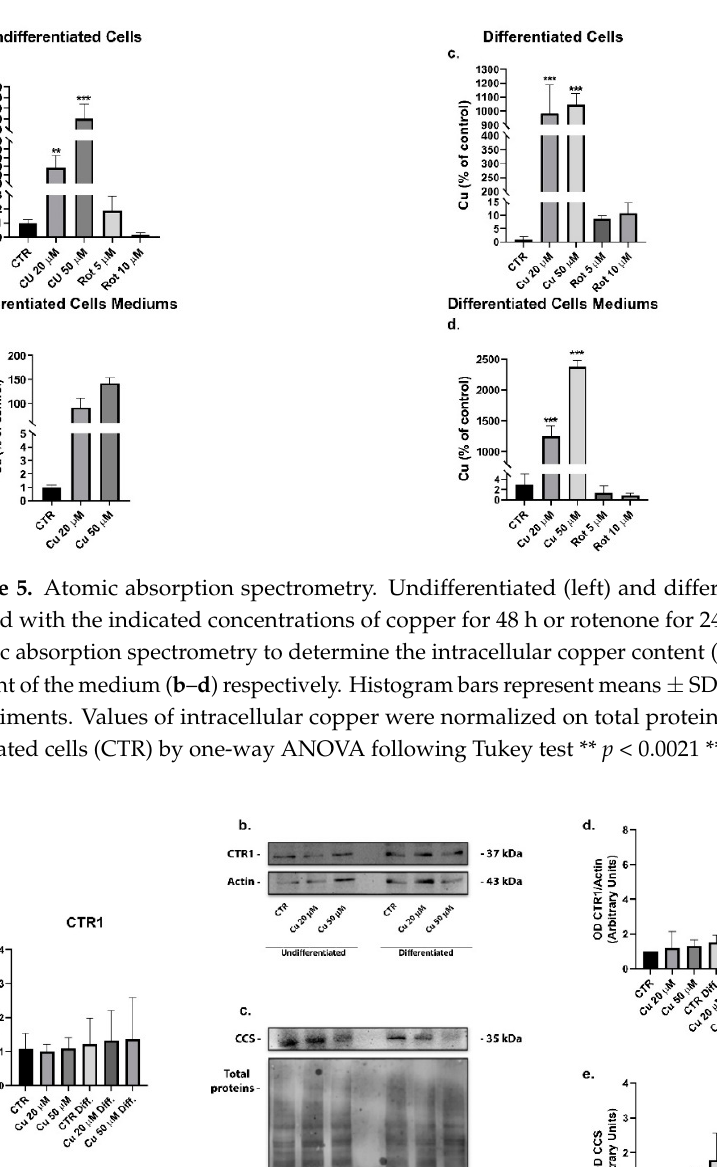
Figure 5. Atomic absorption spectrometry. Undifferentiated (left) and differentiated (right) cells treated with the indicated concentrations of copper for 48 h or rotenone for 24 h were analyzed by atomic absorption spectrometry to determine the intracellular copper content ( a – c ) and the resid- ual content of the medium ( b – d ) respectively. Histogram bars represent means ± SD of three inde- pendent experiments. Values of intracellular copper were normalized on total protein and com- pared with untreated cells (CTR) by one-way ANOVA following Tukey test ** p < 0.0021 *** p < 0.0002.